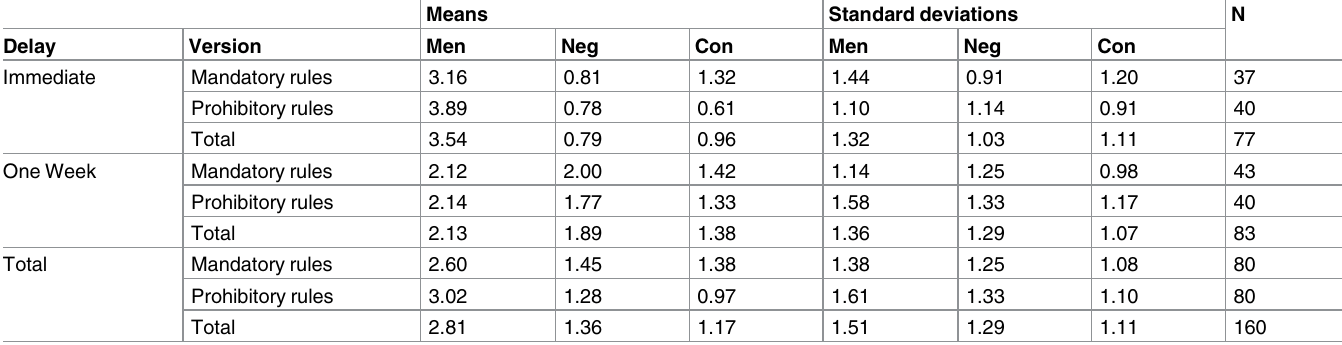
Table 3. Means and standard deviations for the ‘Present’ answers across the experimental conditions–Experiment